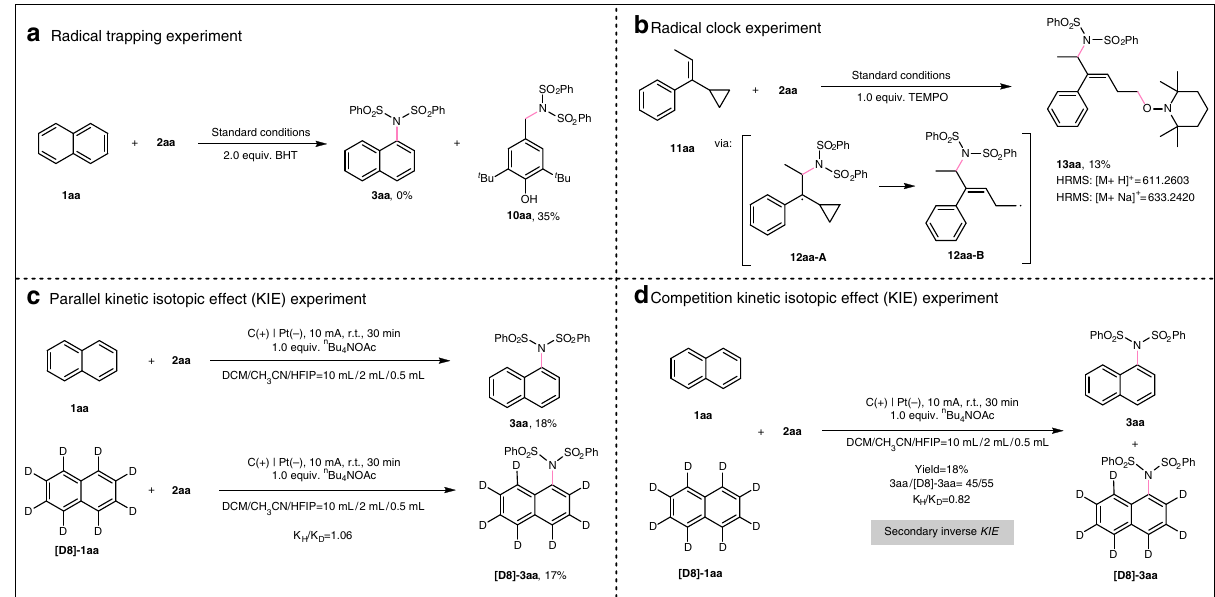
Fig. 7 Mechanistic experiments. a Radical trapping experiment. b Radical clock experiment. c Parallel kinetic isotopic effect experiment. d Competition kinetic isotopic effect experiment.